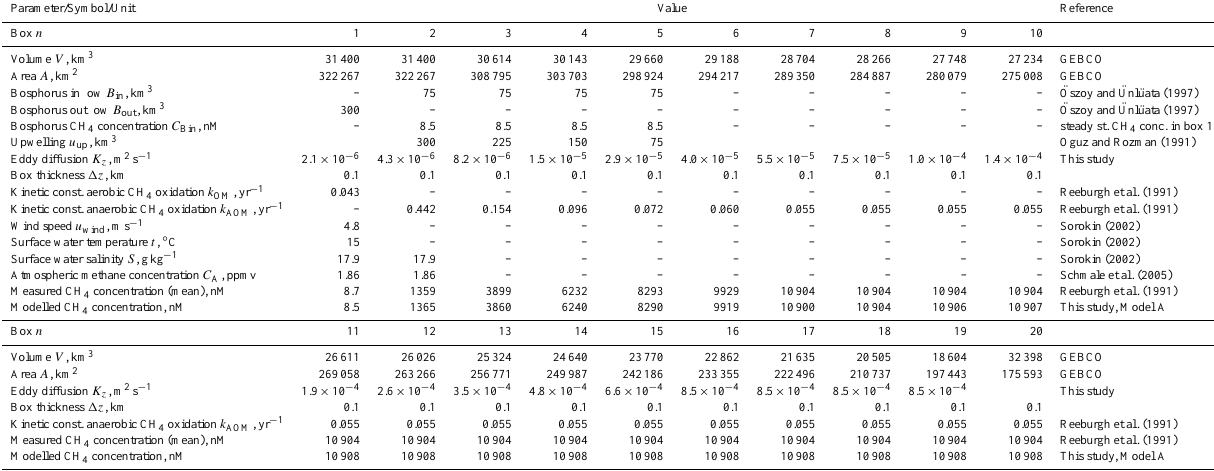
Table 1. Parameter values, notations, and references. Parameter/Symbol/Unit